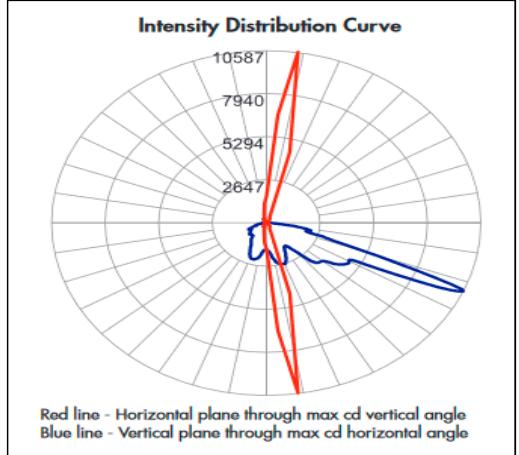
Figure 1. The intensity distribution curve of LEDs.